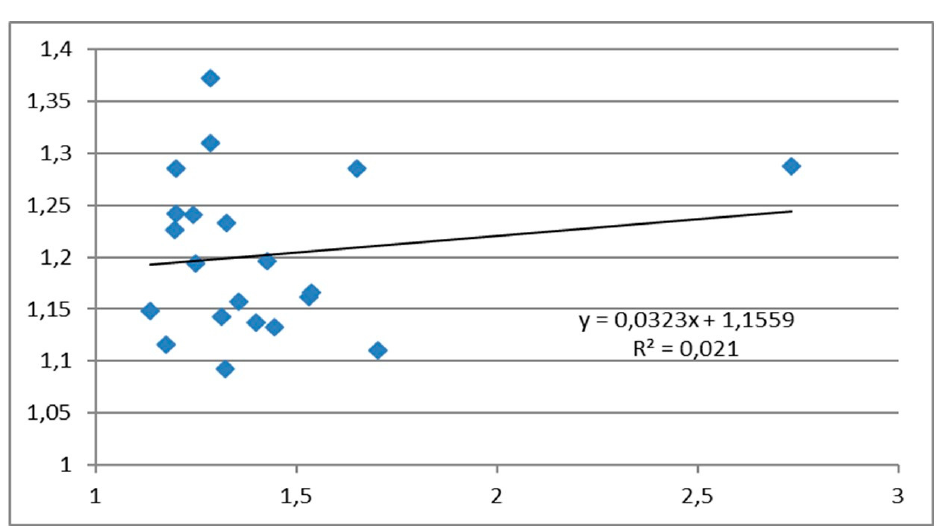
Figure 3. Correlation between HMDR clin and HMDR echo in patients with morbid obesity.